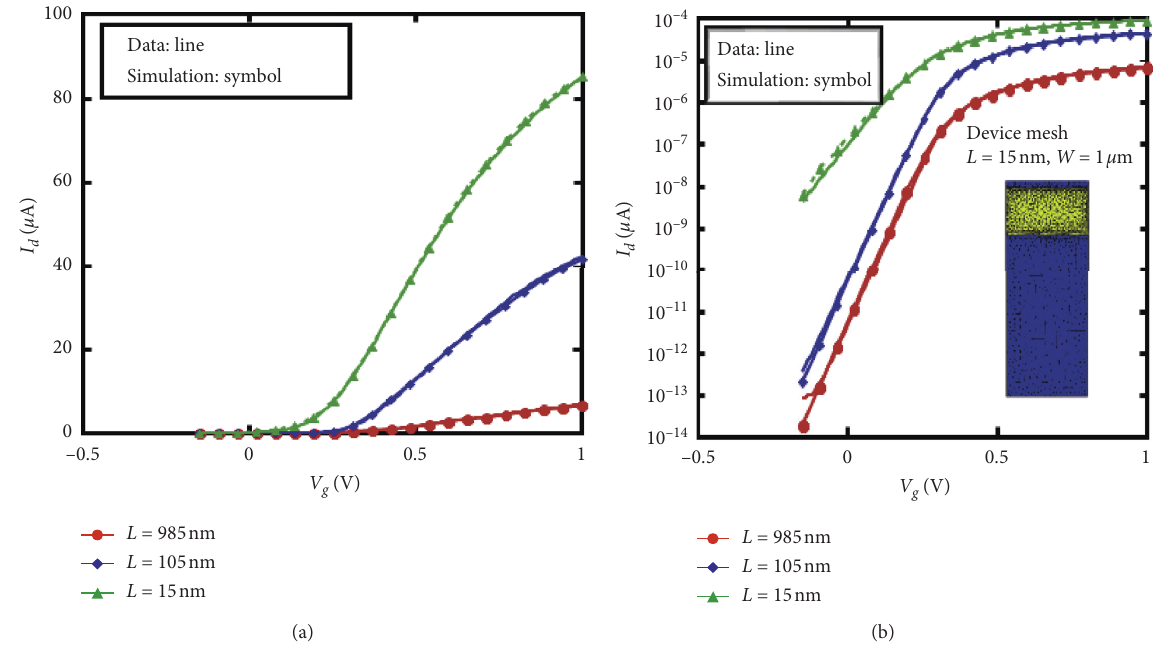
Figure 2: 2D simulation results of I ds - V gs characteristics for various gate effective lengths and W m and graph (b) is semilogarithmic variations, the insert is the meshed structure of FDSOI ( L �